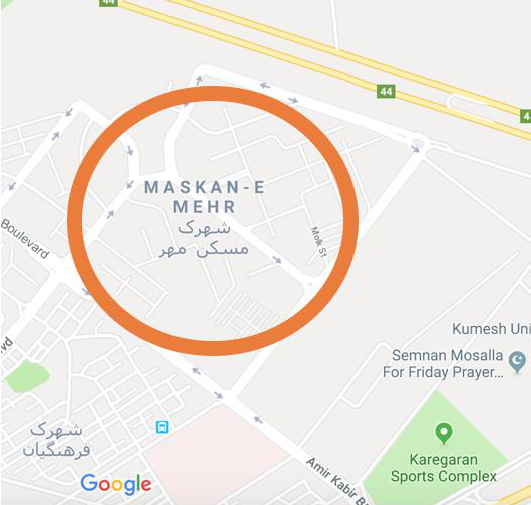
Figure 2 : Semnan Mehr housing inside the city (URL 2)